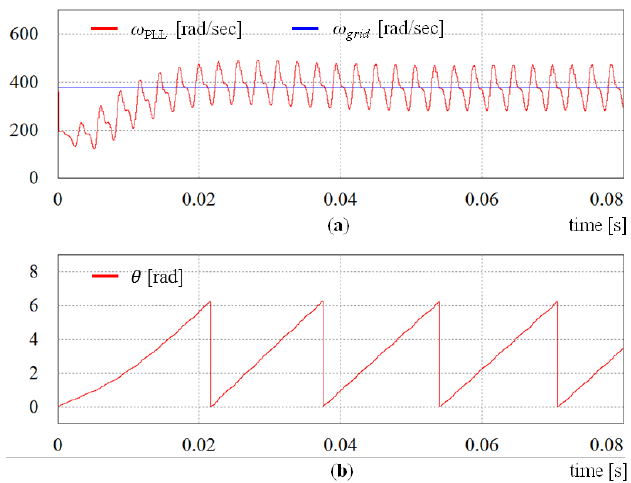
Figure 7. Dynamic response of the conventional synchronous reference frame phase lock loop (SRF-PLL) under the distorted grid voltages: ( a ) angular frequency; and ( b ) angular displacement.